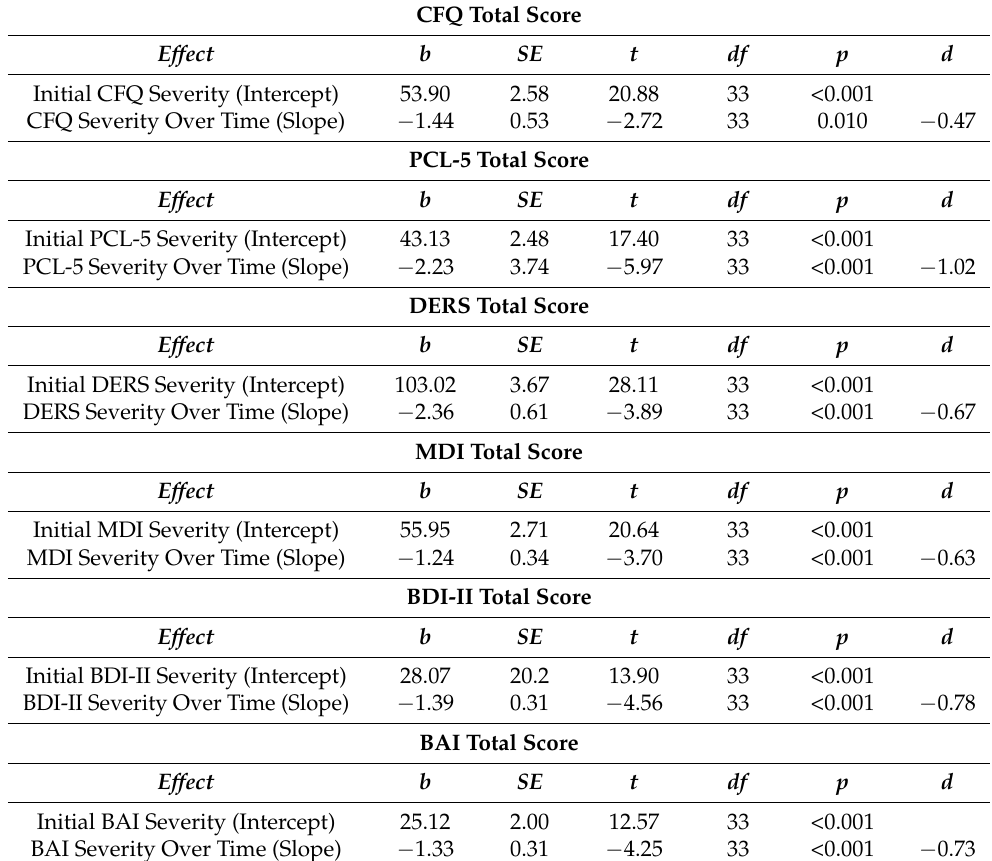
Table 6. Results of hierarchical linear models assessing the trajectory of changes in subjective cognition and self-report symptom measures over time a